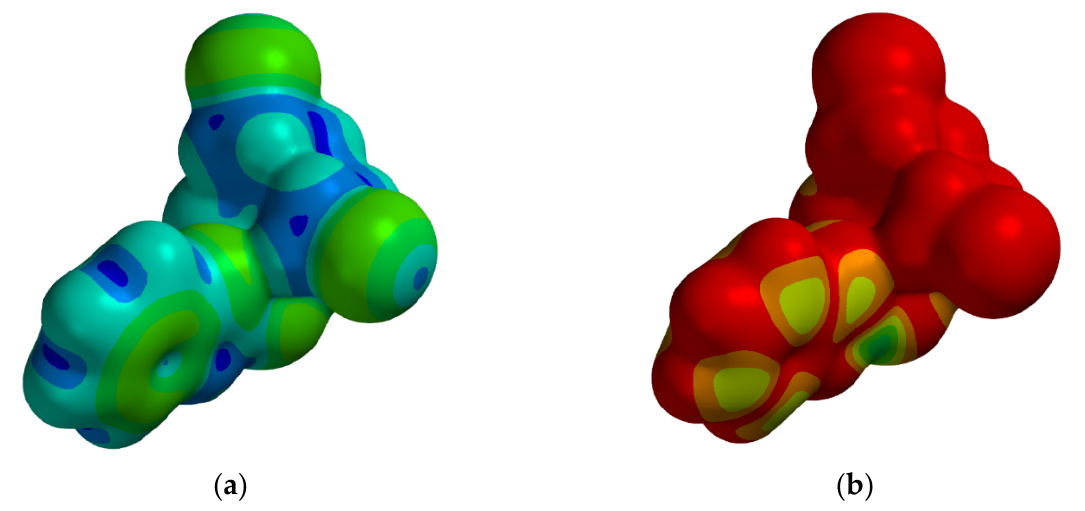
Figure 6. Local ionization map ( a ) and |LUMO| map ( b ) for molecule VIII.